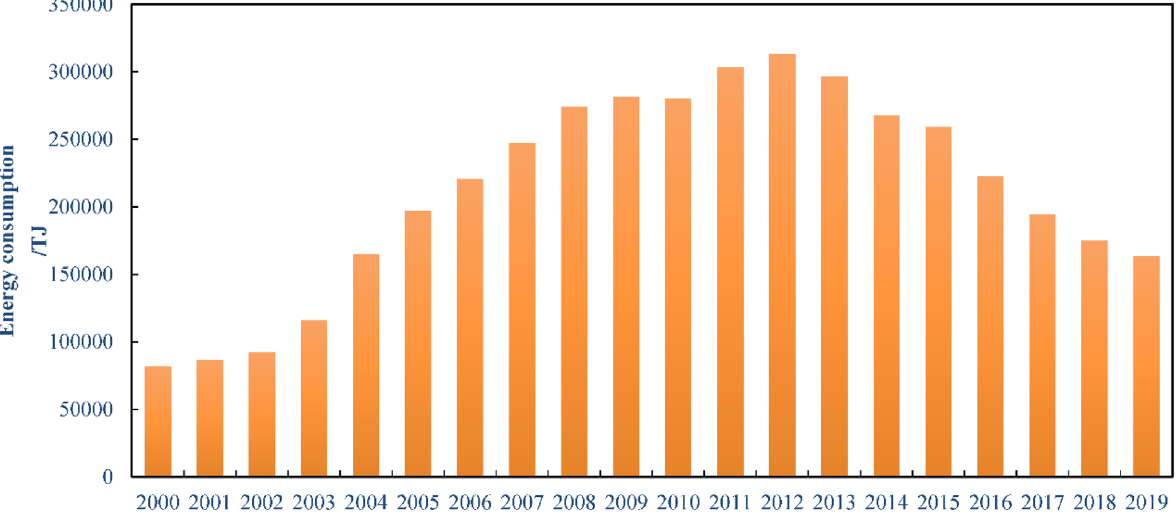
Fig. 1 Energy consumption of the wood and bamboo processing industry in China from 2000 to